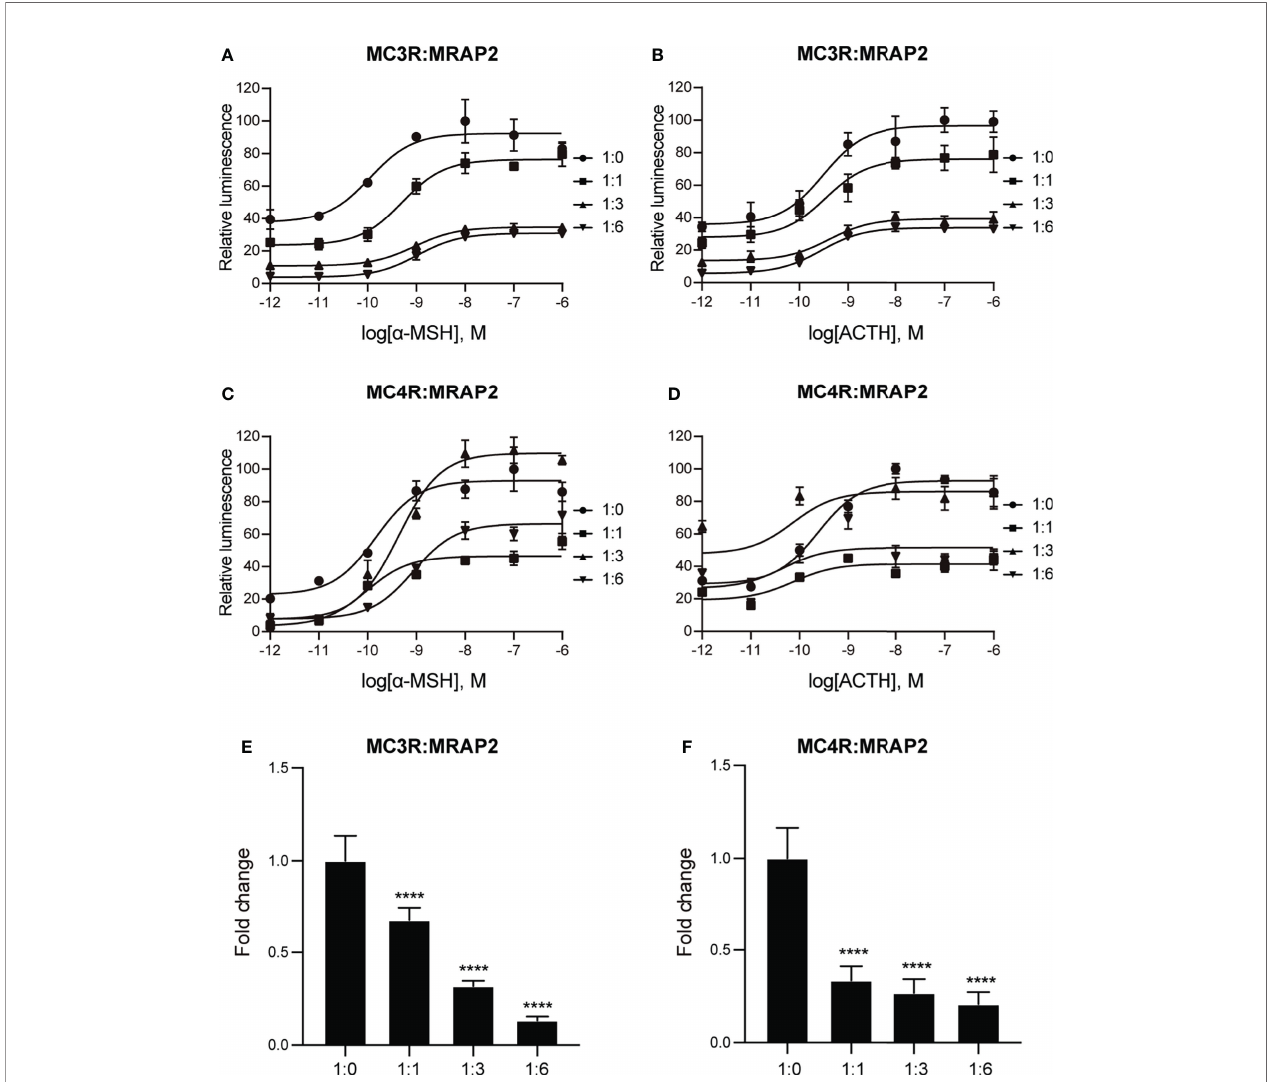
FIGURE 5 | Pharmacological modulation of axolotl MC3R and MC4R by a -MSH and ACTH. (A) Effect of different doses (10 − 12 – 10 − 6 M) of a -MSH in activating axolotl MC3R in the presence of axolotl MRAP2 in HEK293T cells measured with Dual-glo luciferase assay. (B) Effect of different doses (10 − 12 – 10 − 6 M) of ACTH in activating axolotl MC3R in the presence of axolotl MRAP2 in HEK293T cells measured with Dual-glo luciferase assay. (C) Effect of different doses (10 − 12 – 10 − 6 M) of a -MSH in activating axolotl MC4R in the presence of axolotl MRAP2 in HEK293T cells measured with Dual-glo luciferase assay. (D) Effect of different doses (10 − 12 – 10 − 6 M) of ACTH in activating axolotl MC4R in the presence of axolotl MRAP2 in HEK293T cells measured with Dual-glo luciferase assay. (E, F) The constitutive activity of MC3R/MC4R in the presence of different amounts of MRAP2. ****p < 0.0001.